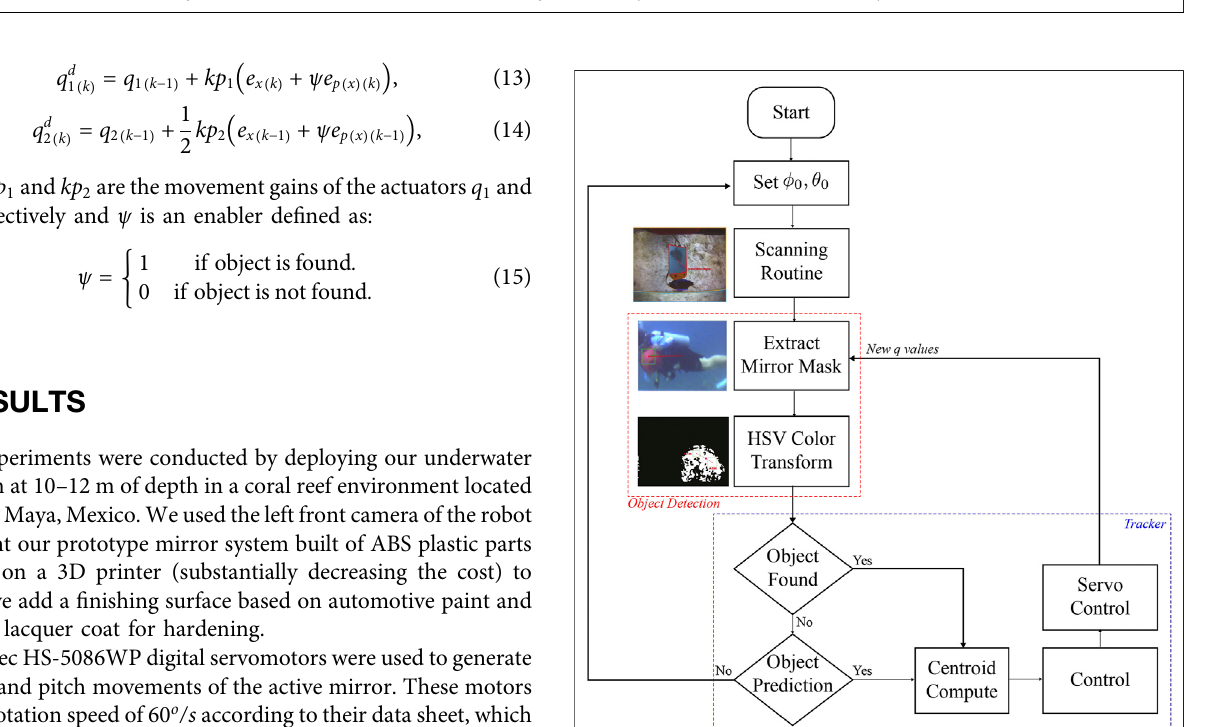
FIGURE 11 | Photography of the prototype of mirrors mounted in the AUV in the fi eld trials at 10 m deep. The cylindrical module under the robot contains all the control electronics of the mirror system, as well as the communication circuits by means of optical fi ber with the robot ’ s computer.